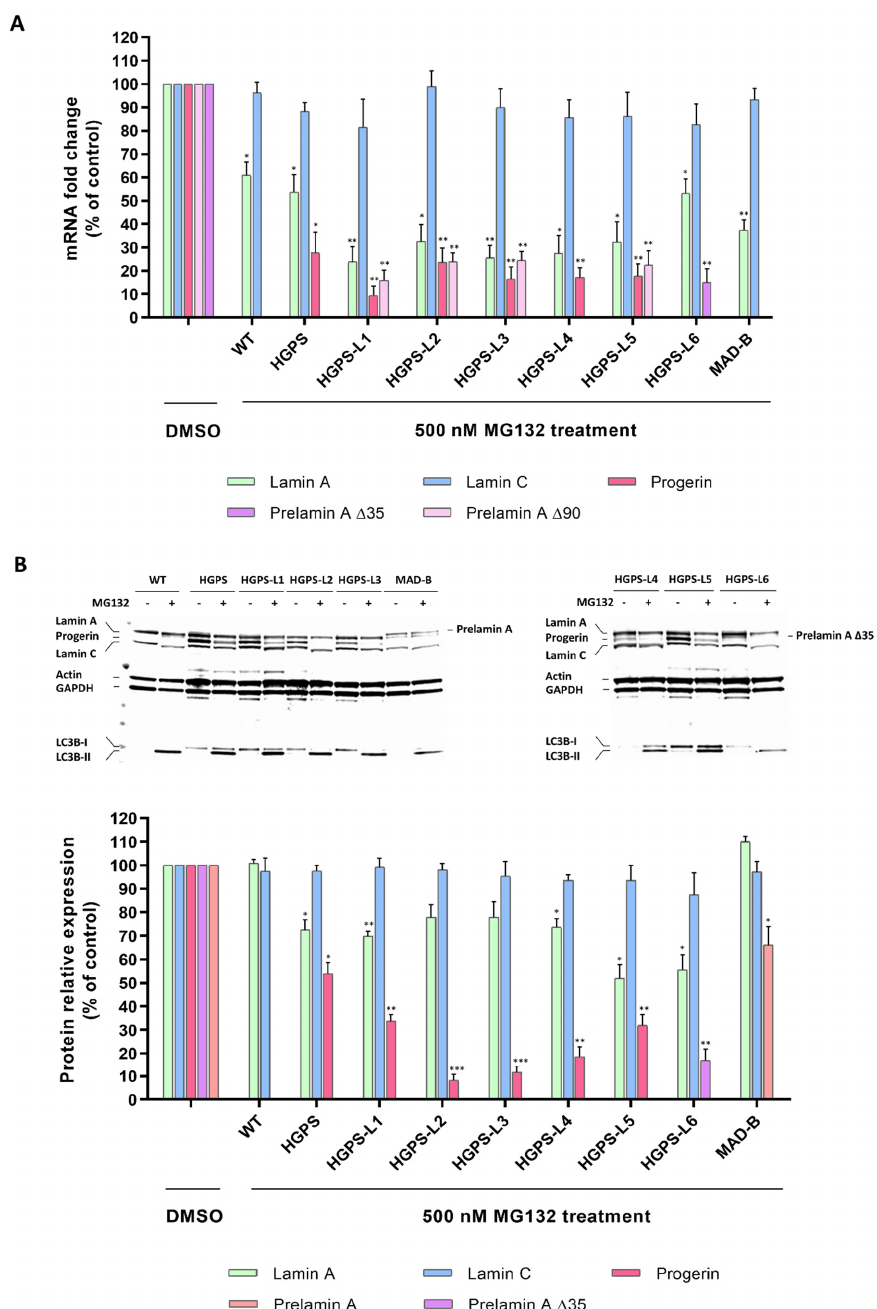
Figure 2. MG132 reduces aberrant prelamin A levels in HGPS-like and MAD-B fibroblasts. ( A ) Downregulation of aberrant prelamin A transcripts ( ∆ 50: progerin, ∆ 35, ∆ 90, and WT prelamin A) in response to MG132. Quantitative real-time PCR analyses of lamin A, prelamin A ∆ 50 (progerin), prelamin A ∆ 35, prelamin A ∆ 90, lamin C, and RPS13 mRNA levels in HGPS, HGPS-like, MAD-B, and WT fibroblasts treated for 24 h with 500 nM MG132 relative to DMSO-treated cells (Control). The fold change of each transcript was determined by normalizing its value to that of RPS13 for each condition. (mean ± SEM, n = 4, Student’s t -test, * p < 0.05, ** p < 0.01, experimental vs. control). ( B ) MG132 reduced aberrant prelamin A protein levels in HGPS-like and MAB-B patient cells. Upper panels: Western blotting evaluation of lamin A/C, progerin, prelamin A, prelamin A ∆ 35 in whole-cell lysates from WT, HGPS, HGPS-like, and MAD-B fibroblasts treated with DMSO ( − ), 500 nM MG132 for 48 h (+). Lower panels: lamin A/C, progerin, prelamin A, prelamin A ∆ 35 expression levels were normalized to GAPDH values using ImageJ software. (mean ± SEM, n = 3, Student’s t -test, * p < 0.05, ** p < 0.01, *** p < 0.001. MG132-treated vs. DMSO-treated